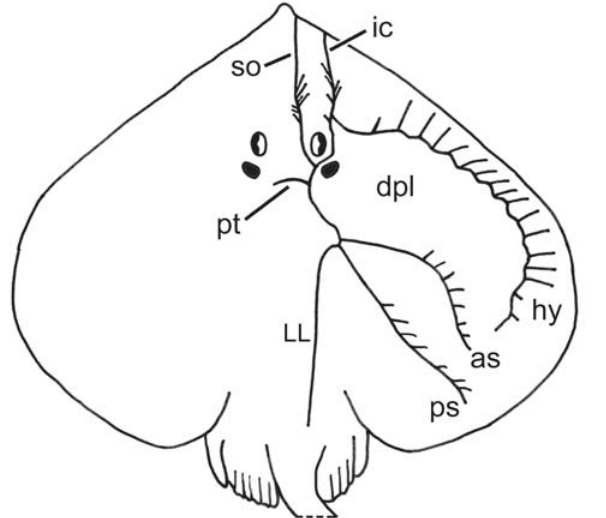
Fig. 8. Schematic illustration of dorsal lateral line canals of Malacoraja obscura , n. sp. (based mostly on MNRJ 28289, 680 mm TL). Abbreviations: as , anterior scapular canal; dpl , dorsal pleural loop; hy , hyomandibular canal; ic , infraorbital canal; LL , posterior lateral line canal; ps , posterior scapular canal; pt , posttemporal canal; so , supraorbital canal. Note that hyomandibular canal appears restricted to dorsal surface (see text for description). For simplicity, canals of left side and over tail